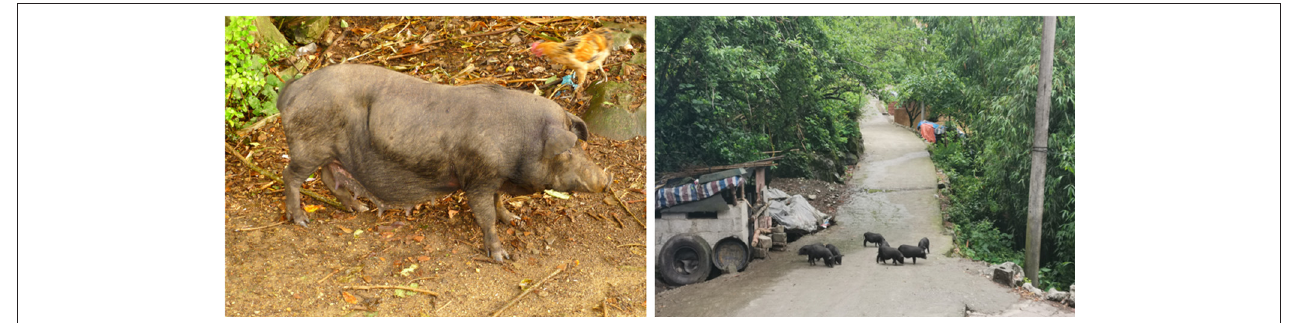
FIGURE 3 | Black pigs kept by Baiku Yao